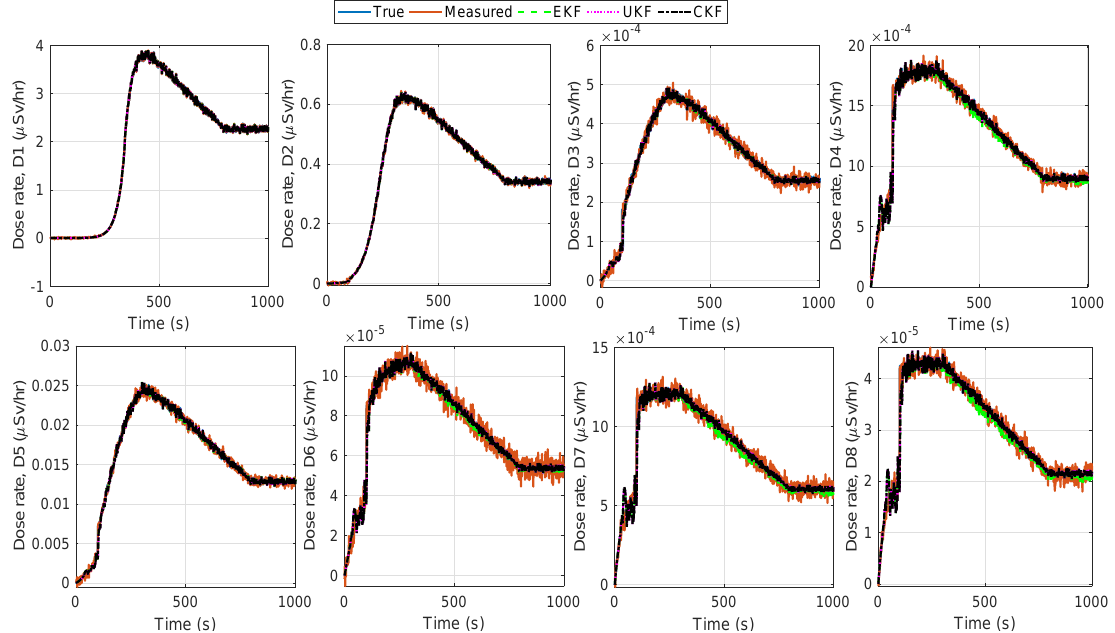
Figure 2. True, measured, and estimated dose rates at detectors D1 to D8 for variation in release rate.